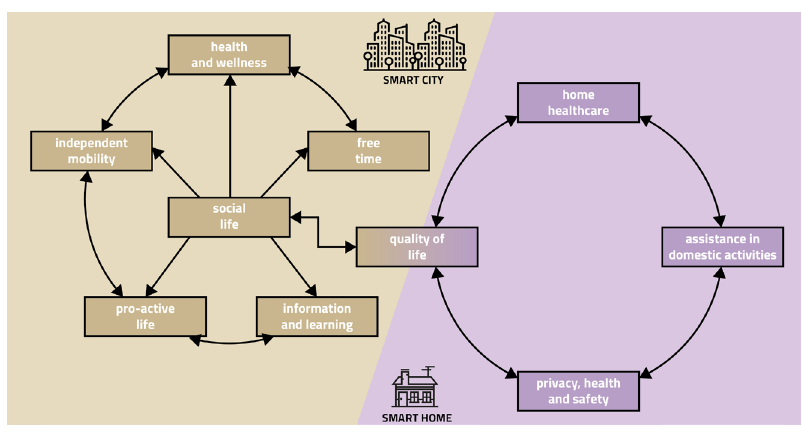
FIG. 1 Relationship between the smart city and the smart home Source: